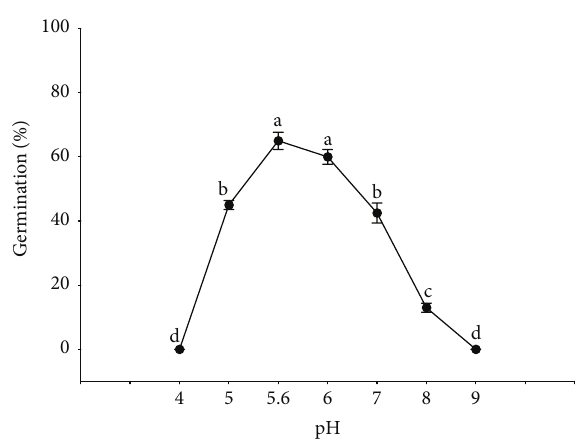
Figure 5: Final percent germination of Rumex confertus seeds as effected by pH after incubating at 22 ∘ C with 12 h photoperiod for 20 days. Means with the same letter do not differ (Tukey’s test at 𝑃 < 0.05 ). Vertical bars represent standard deviations of the means.